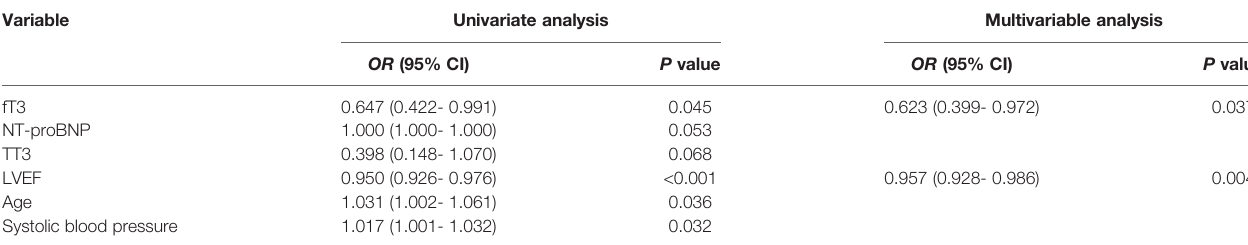
TABLE 3 | Univariate and Multivariable analysis of predictors of MACE within 2 years. Variable